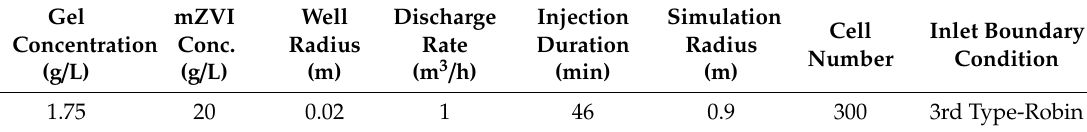
Table 1. Model parameters for the simulation in the radial domain.